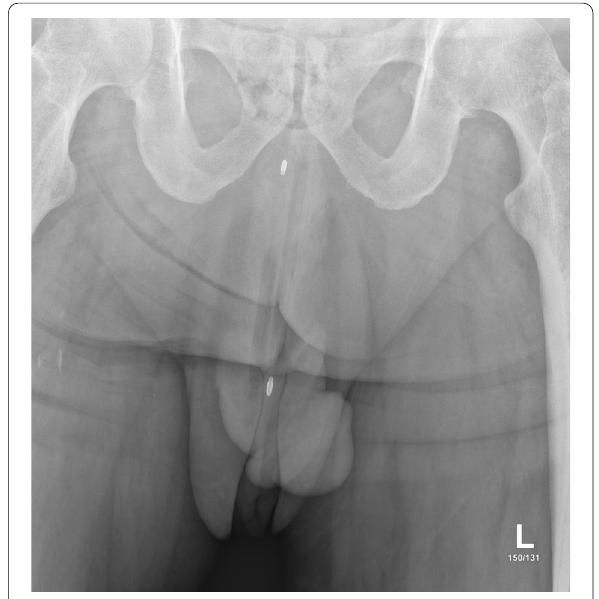
Fig. 1 X-ray of the penoscrotal region shows the radiopaque parts of the foreign bodies